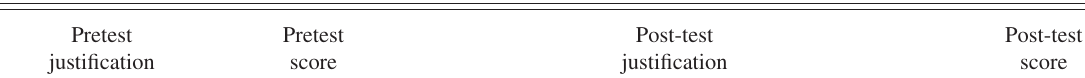
TABLE II. (cid:1) Continued. (cid:2)